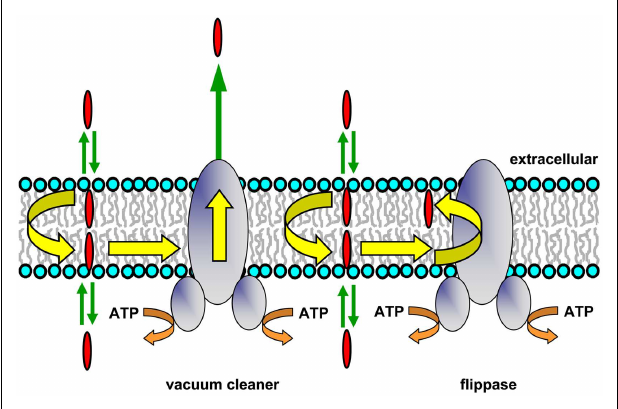
FIGURE 1 | Hydrophobic vacuum cleaner and flippase models of Pgp function . In the vacuum cleaner model, drugs partition into the membrane, spontaneously translocate to the cytoplasmic leaflet, and gain access to the Pgp substrate-binding pocket from within the bilayer interior.They are subsequently effluxed into the extracellular aqueous phase. In the flippase model, drugs partition into the membrane, spontaneously translocate to the inner leaflet, interact with the Pgp substrate-binding pocket, and are then flipped to the outer membrane leaflet.The drug concentration will be higher in the outer leaflet compared to the inner leaflet, and a concentration gradient is generated when drugs rapidly partition from the two membrane leaflets into the aqueous phase on either side of the